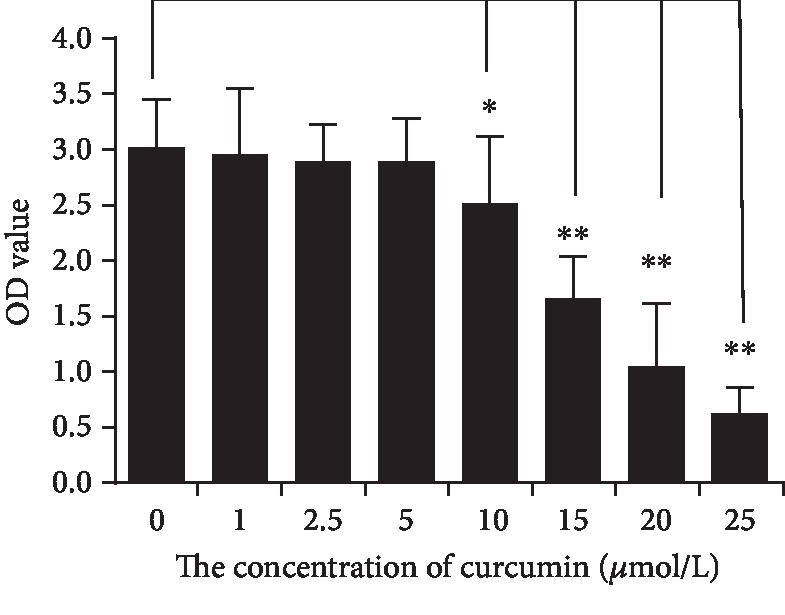
CCK-8 assay to examine the proliferation of hUC-MSCs activated with different concentrations of CUR. CUR did not stimulate proliferation and apoptosis at a concentration ranging 0-5 μmol/L. When the concentration of CUR was >10 μmol/L, apoptosis of hUC-MSCs occurred (∗p < 0.05 and ∗∗p < 0.01, Student's t-test; all experiments were performed thrice).